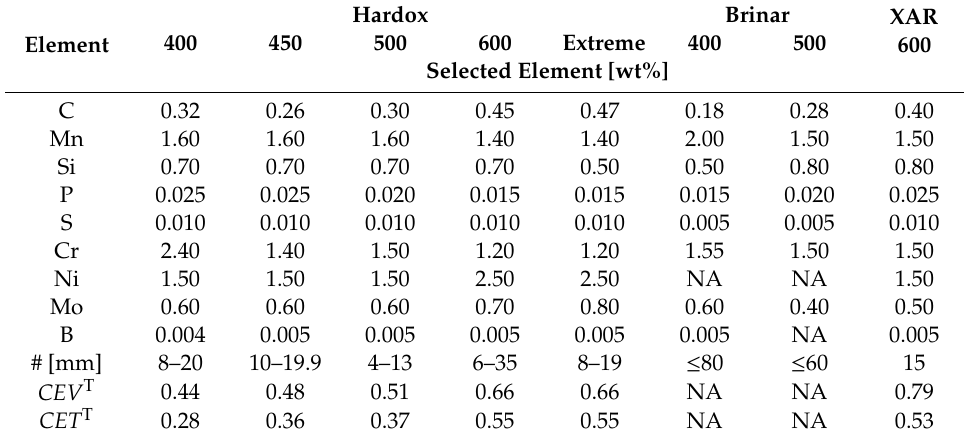
Table 2. Chemical compositions and declared carbon equivalents of selected abrasive-wear resistant steels